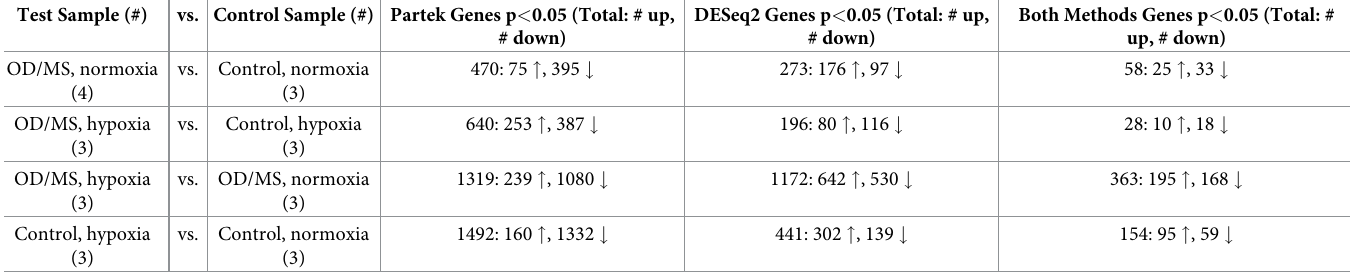
Table 3. The numbers of differentially expressed genes with a p-value less than 0.05 are shown for each comparison. See S1–S4 Tables for full lists of significant differ- entially expressed genes. Test Sample (#) vs. Control Sample (#) Partek Genes p < 0.05 (Total: # up, #